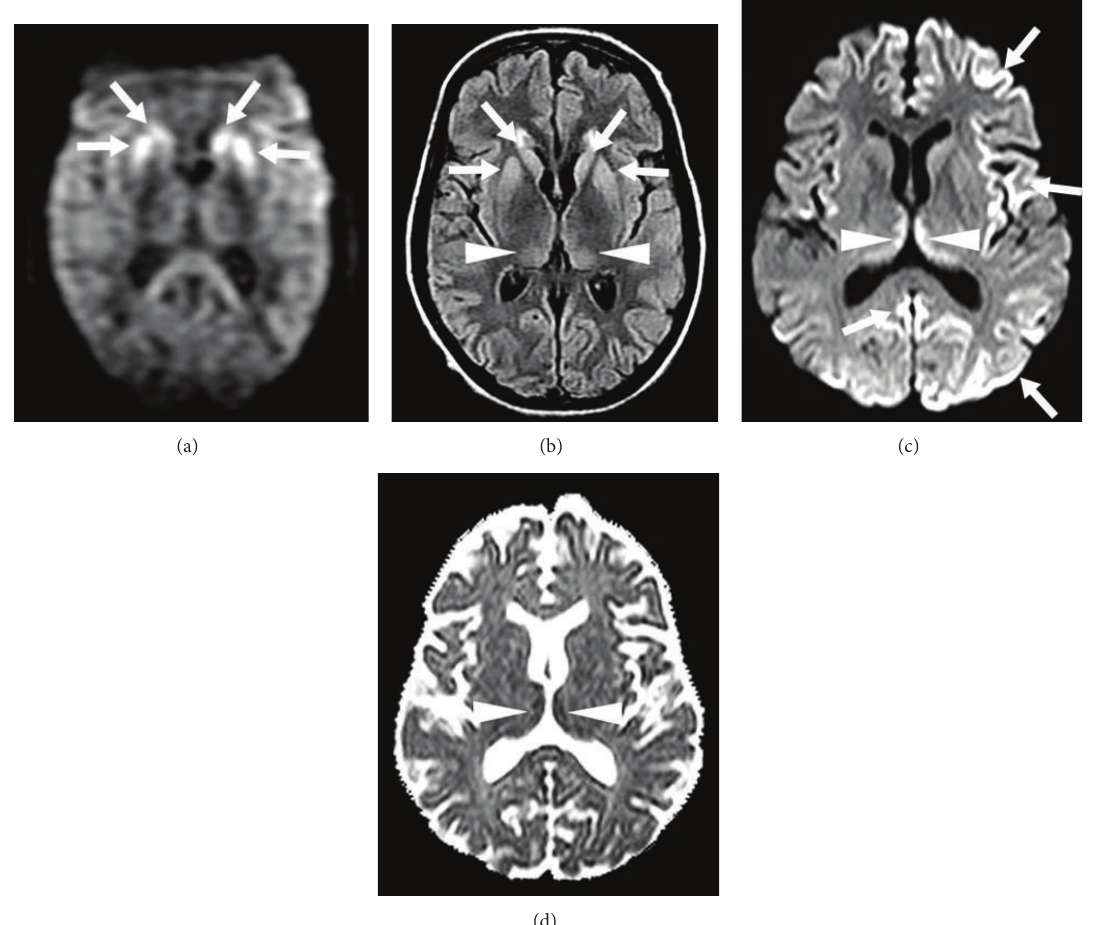
Figure 23: Two different sporadic CJD patients (patient 1, a and b; patient 2, c and d) showing in patient 1 bilateral caudate nucleus and putaminal (arrows) and to a lesser degree posteromesial and pulvinar thalamic (arrowheads) hyperintensities on DWI (a) and FLAIR imaging (b) and in patient 2 bilateral posteromesial thalamic (arrowheads) and multifocal cortical (arrows) hyperintensities on DWI (c), seen as hypointensity on ADC map (d). Anterior predominance of the thalamic involvement can be seen in patient